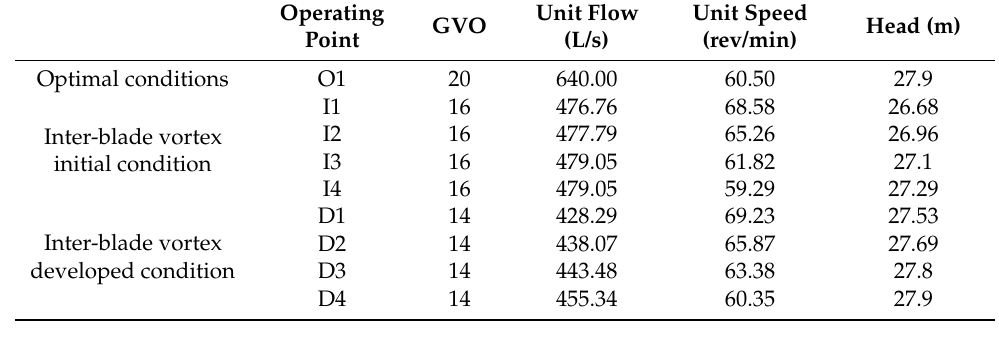
Table 3. Operating point listings.